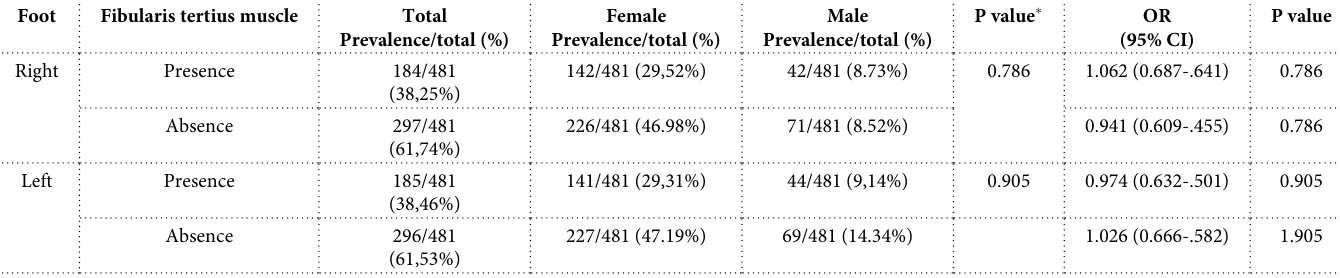
Table 3. Comparison of the presence and absence of the fibularis tertius muscle in the right and left feet in males and females in a population in Spain.